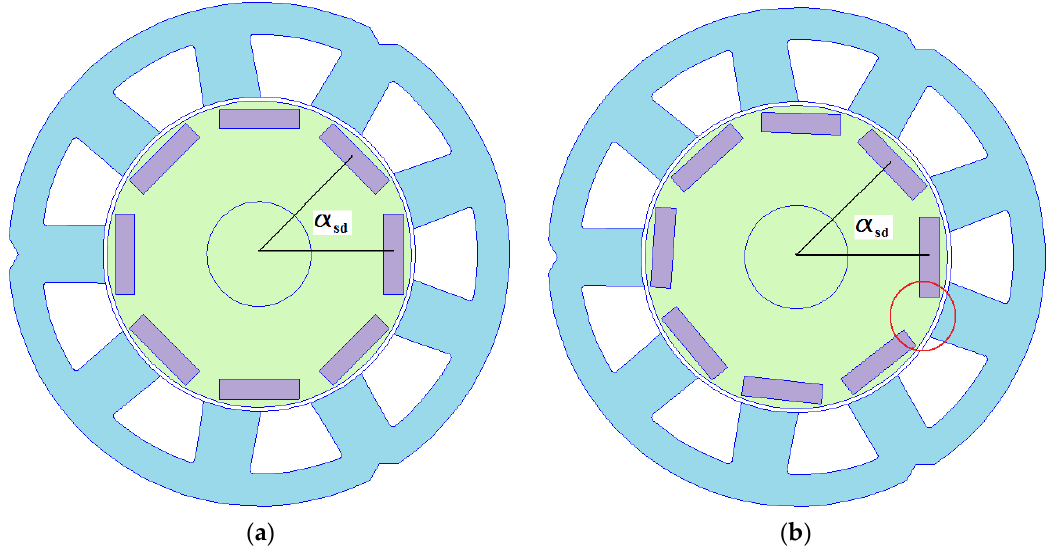
Figure 3. Example of the asymmetric machine with the symmetric rotor ( a ) and the asymmetric rotor ( b ).